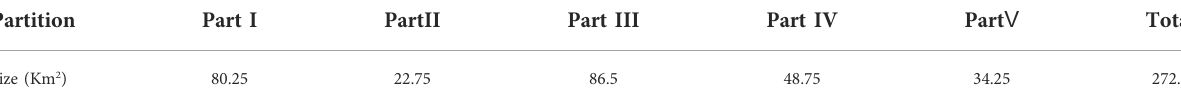
TABLE 1 Partition area table of Da Huang Pu fl ood storage and detention area.